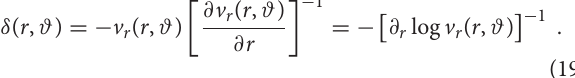
0.57 (Left) and r ub 0.67 (Right) . The upper = = r ub / r o =